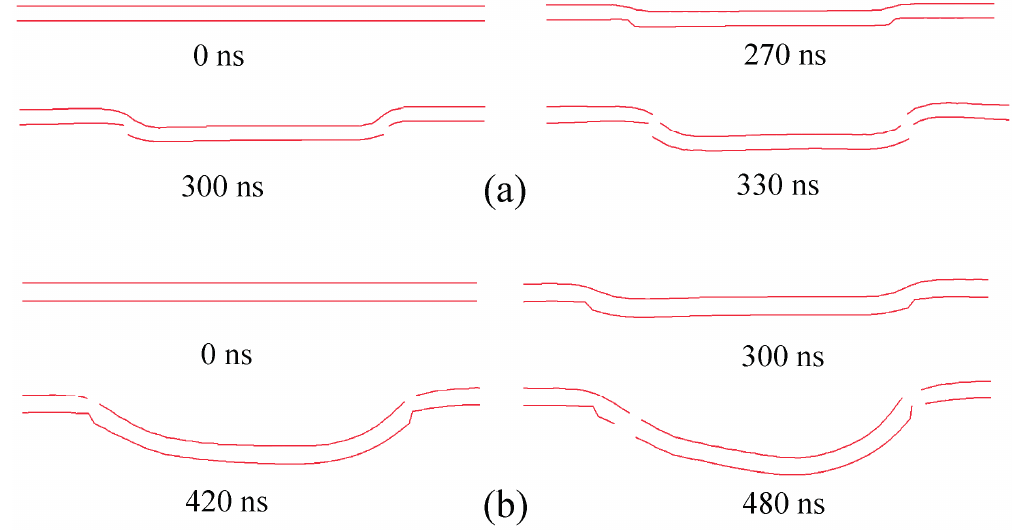
Figure 13. Differences in material deformation between high and low laser energy in the cross section ( a ) high energy and ( b ) low